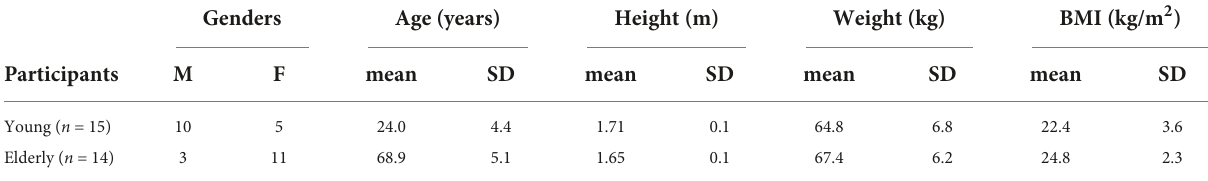
TABLE 1 Descriptive statistics of the